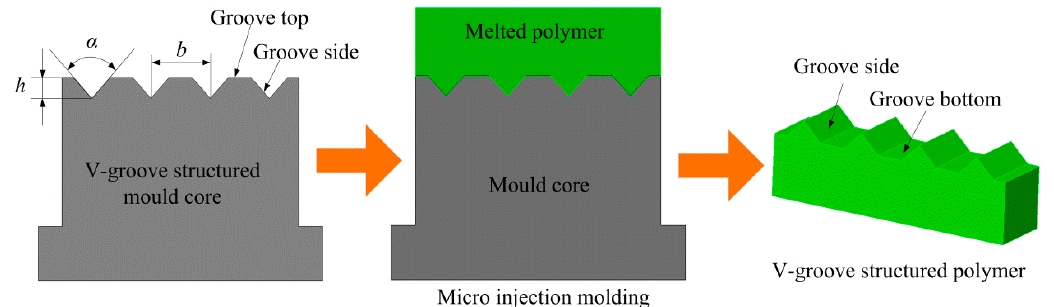
Figure 4. Principle of micro injection molding of the micro-structured polymer.